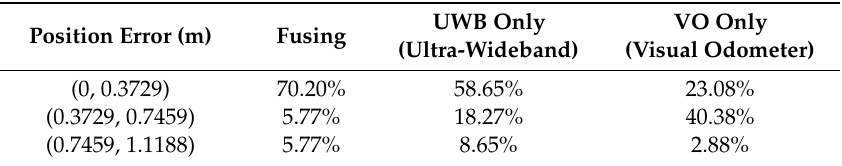
Table 2. Percentage of location points in the x direction.